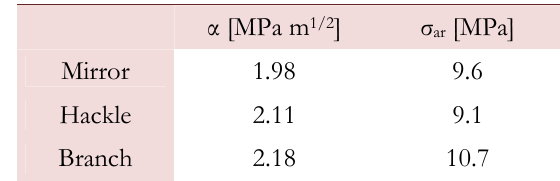
Table 1: Parameters of the crack branching equation for annealed glass.